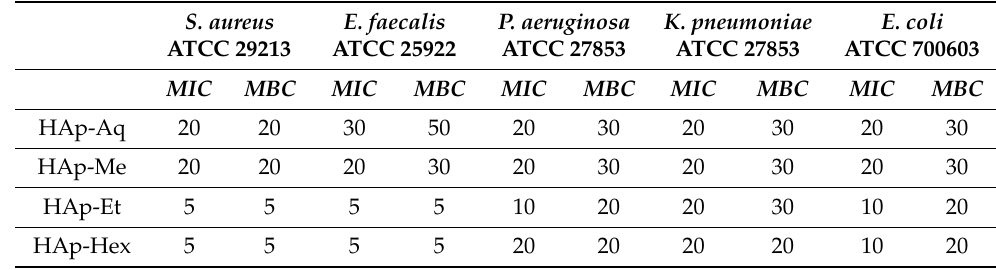
Table 2. MIC and MBC in mg/mL of Nigella sativa -loaded fractions in HAp 3D scaffolds against tested